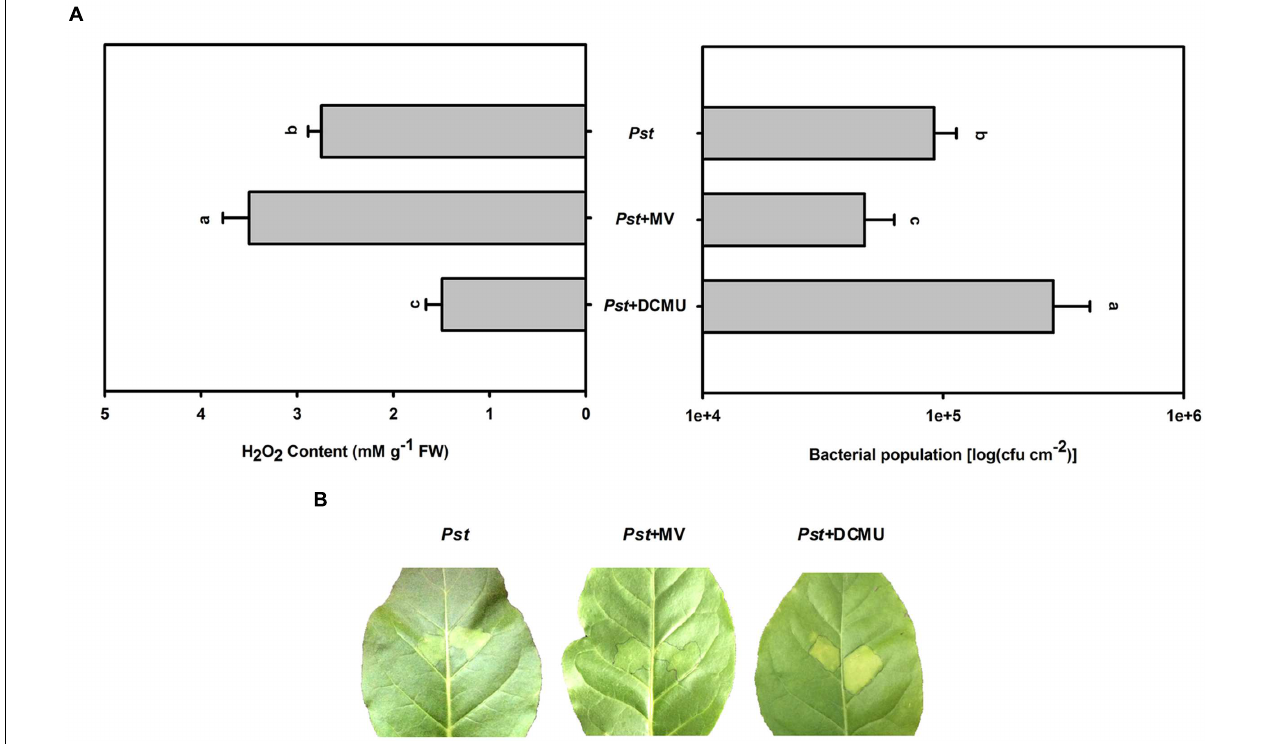
FIGURE 8 | The effect of MV or DCMU pretreatment on H 2 O 2 accumulation and the Pst population after Pst infection in tobacco leaves under light conditions. (A) The H 2 O 2 accumulation and the Pst population in tobacco leaves after pretreatment with MV or DCMU prior to Pst infiltration under light conditions (200 µ mol m − 2 s − 1 ). Means ± SE of six replicates are presented. Different letters above the columns indicate significant differences between treatments at P < 0.05. (B) Representative images of changes in tobacco leaves pretreated with MV or DCMU at 3 dpi under light